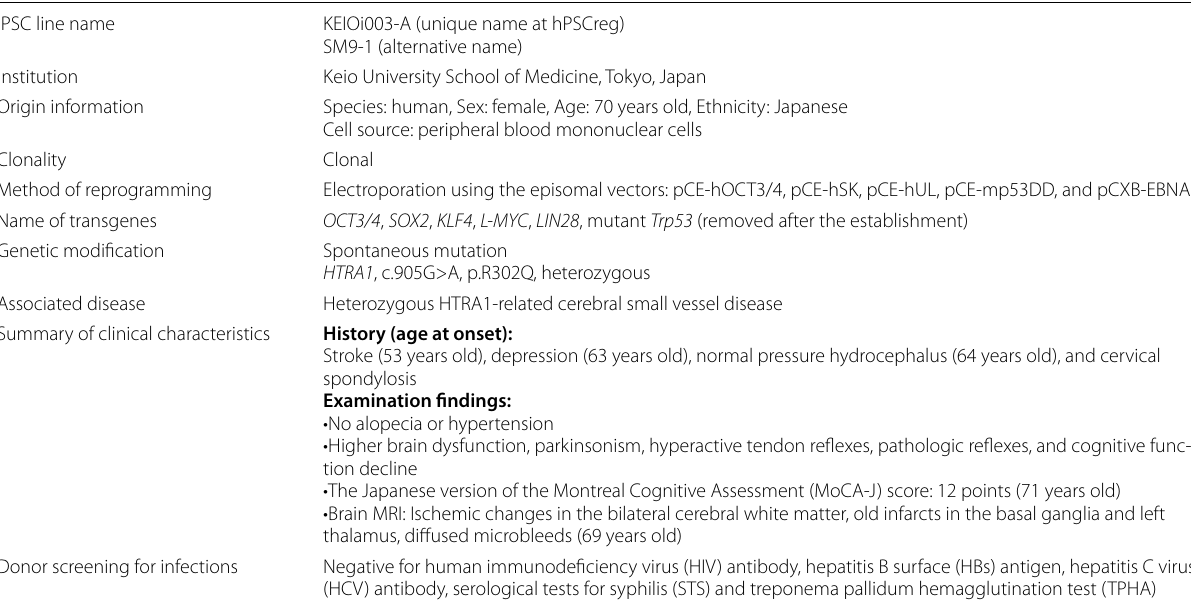
Table 1 Resource information of the established iPSC line iPSC line